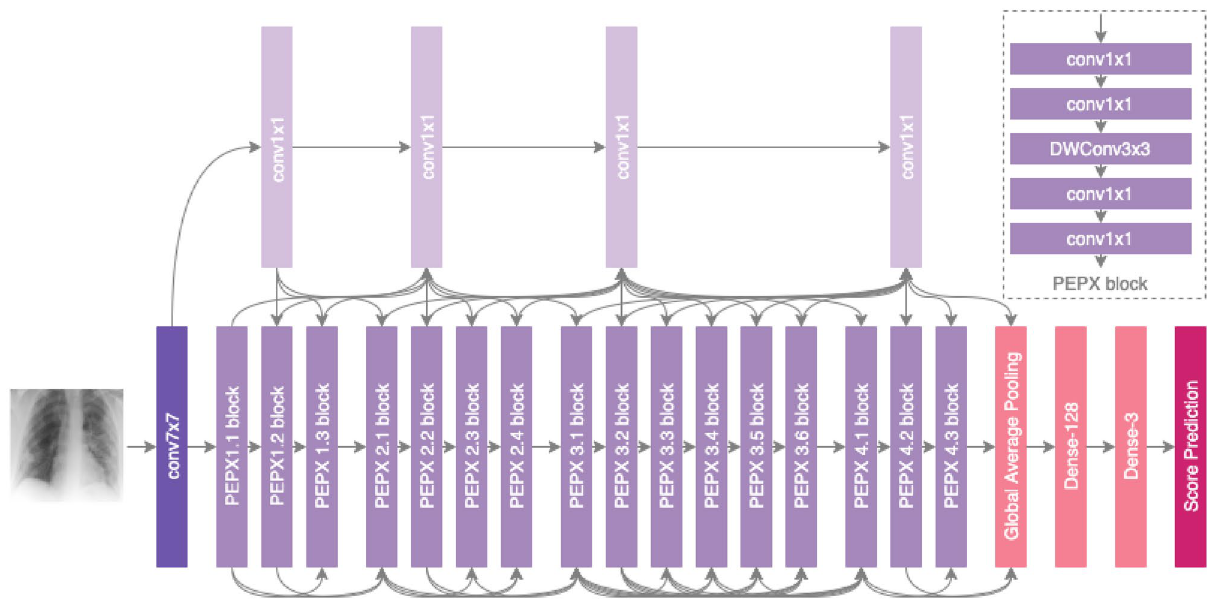
Figure 1. Flowchart of the overall architecture of the COVID-Net S deep neural networks for predicting SARS- CoV-2 severity